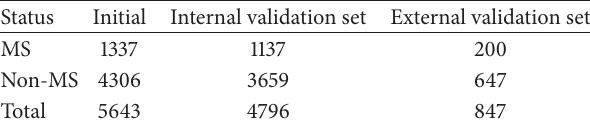
Table 2: The number of subjects used as internal and external validation sets for predicting MS.